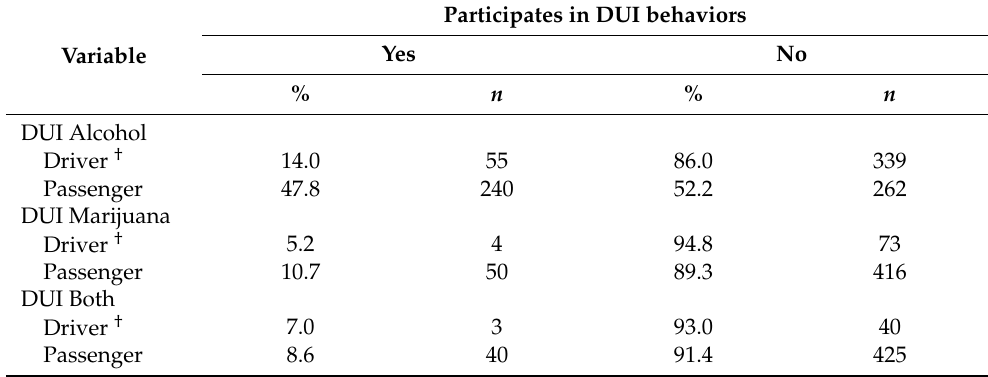
Table 3. Participation in DUI